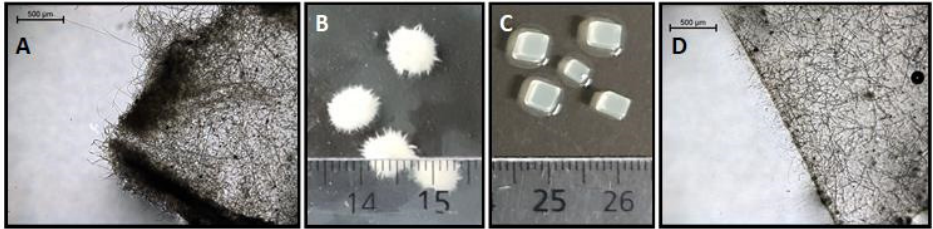
Figure 4. A. oryzae immobilized in 3% agar in the beginning ( A ), after 48 h ( B ), and after 240 h ( C , D ) of incubation in main culture medium containing acetate.